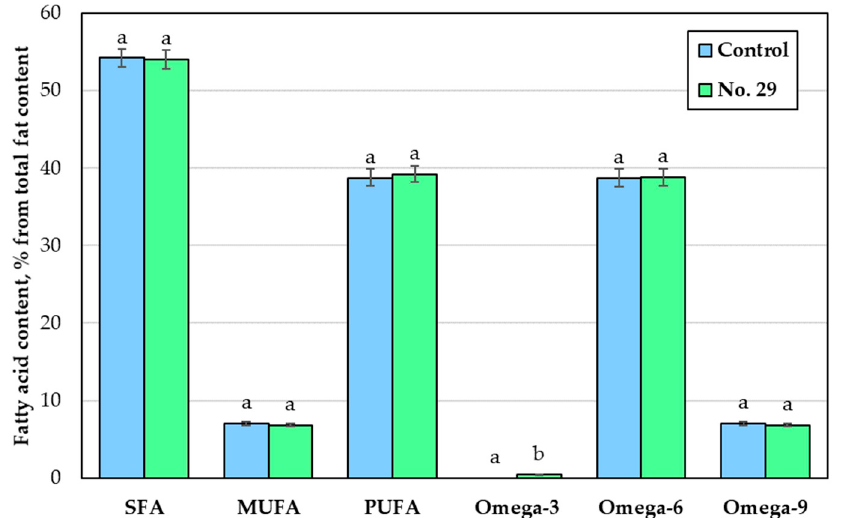
Figure 5. Classi fi cation of fa tt y acids (FA) in the Spirulina samples (Control—Spirulina powder and water mixture, 1:2 w / w ; No. 29—Spirulina samples fermented for 24 h with Pediococcus acidilactici, strain No. 29; SFAs—saturated fa tt y acids; MUFAs—monounsaturated fa tt y acids; PUFAs—polyun-